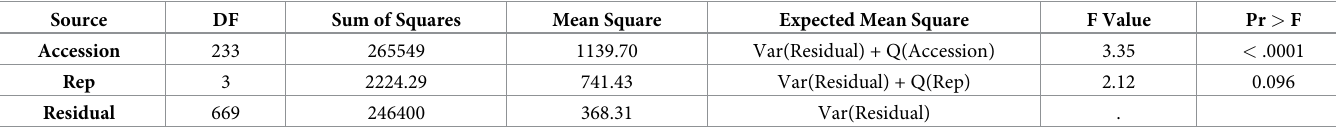
Table 1. ANOVA table for tolerance index based on biomass reduction under SCN infestation among 234 soybean genotypes. Source DF